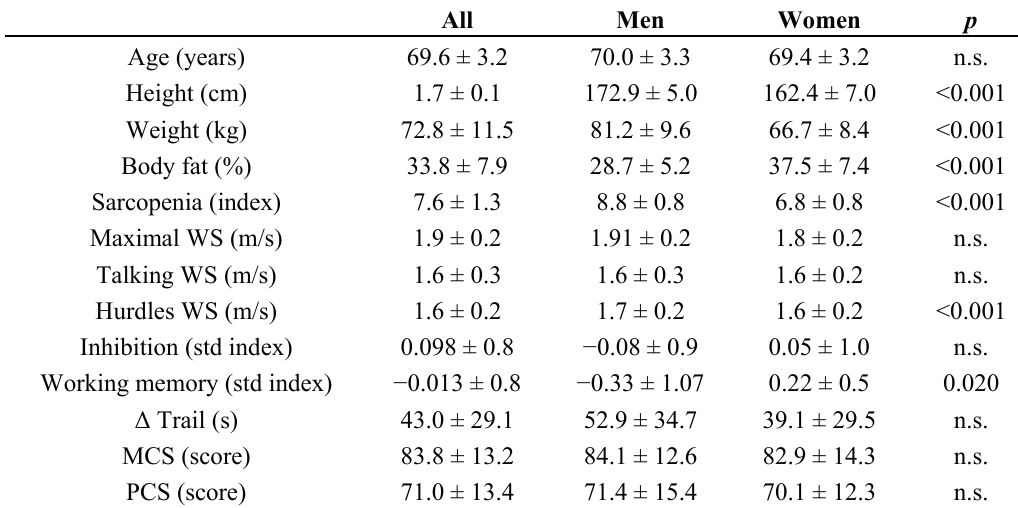
Table 1. Mean ± standard deviation of all variables measured in all participants (n = 56). Significant differences between males and females are also